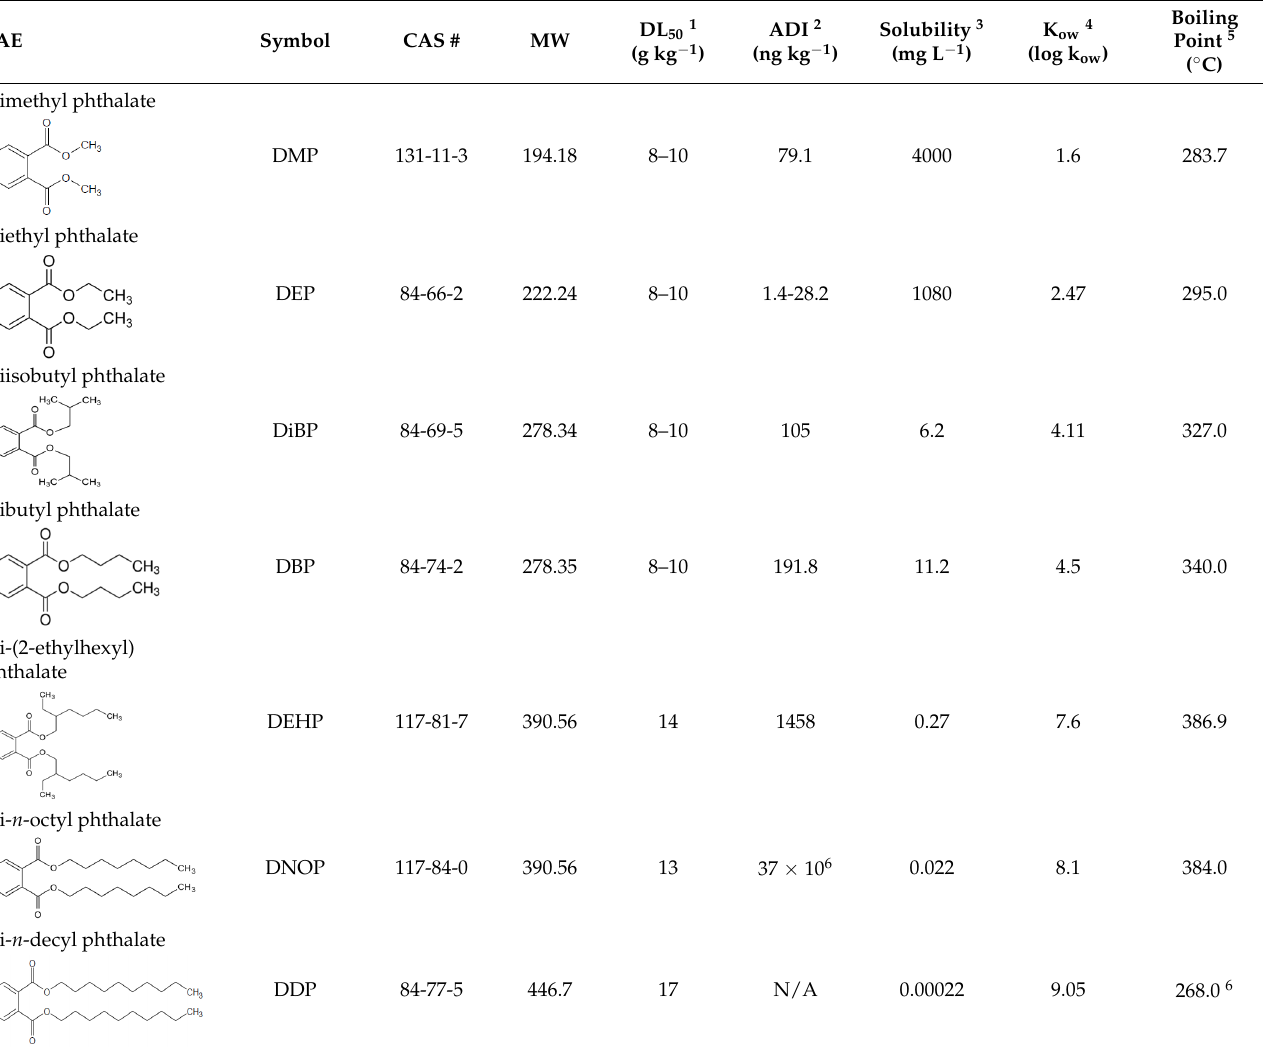
Table 1. Name, chemical structure, acronym, CAS number, molecular weight, lethal dose 50 (DL 50 ), acceptable daily intake (ADI), solubility, octanol–water partition coefficient (K ow ), and boiling point of each phthalate (PAE) investigated in this study.